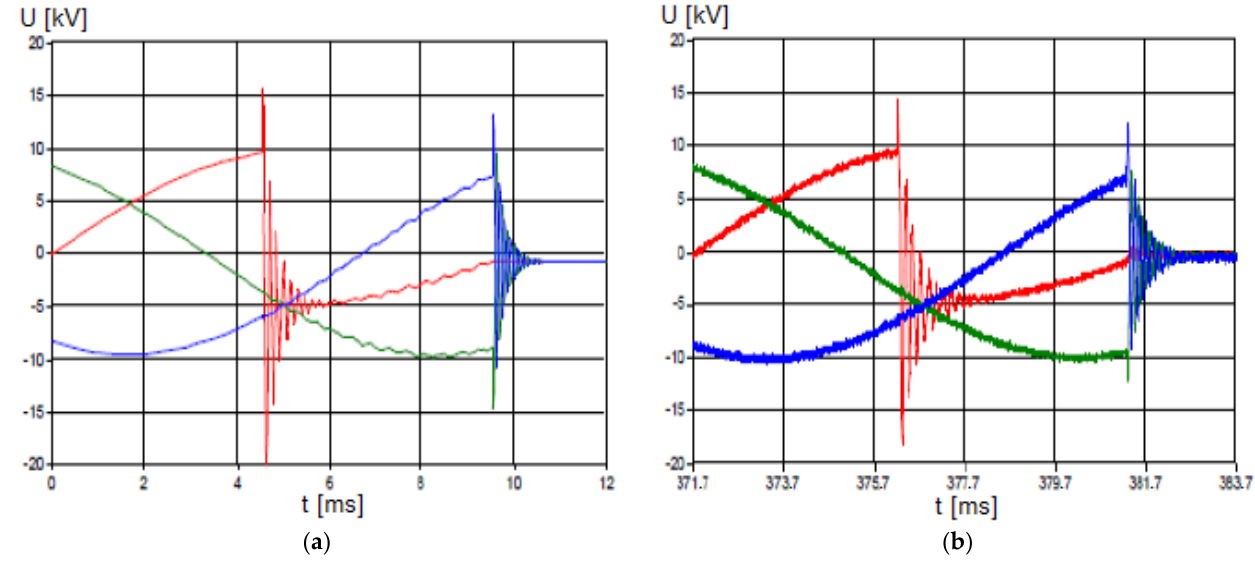
Figure 14. ( a ) Simulation results—Load voltage; ( b ) Measurement results—Load voltage. Source: [1].